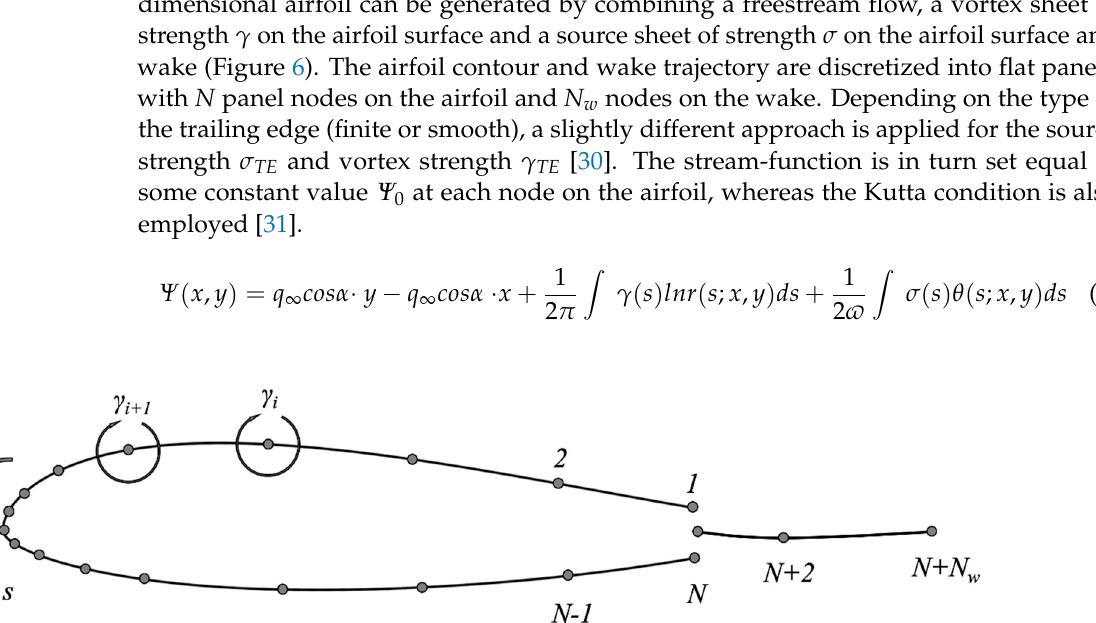
Figure 5. An MH-93 airfoil, as generated by XFOIL from a cloud of points, undeflected (solid line) and with a 20%-chord flap at a 10° deflection (dashed line).